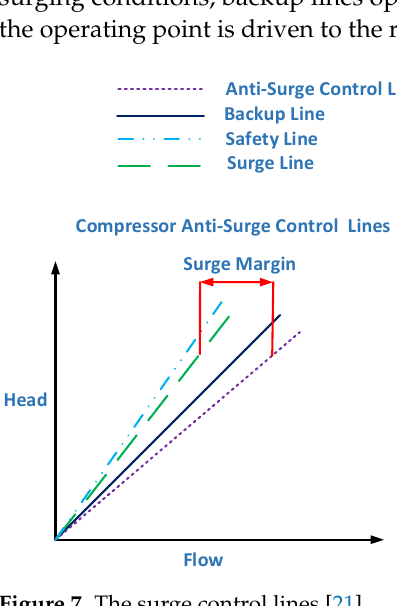
Figure 7. The surge control lines [21].